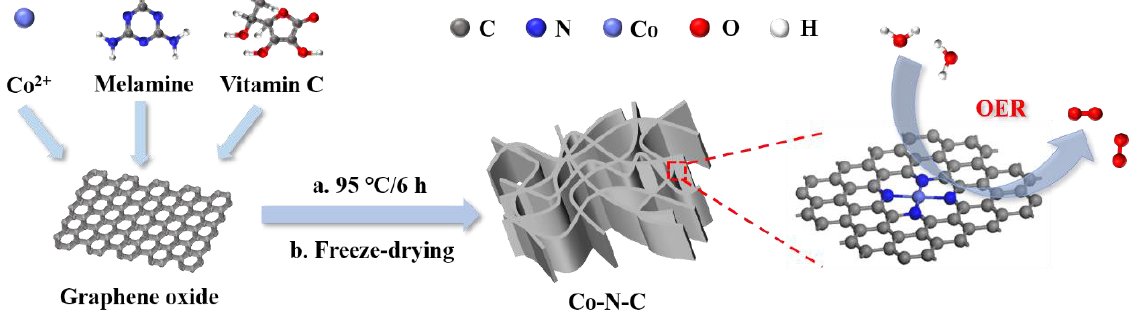
Figure 1. Schematic illustration of the preparation process of the Co-N-C aerogel electrocatalyst. Overall, structural characterization and OER activity of the preferably selected Co- N-C (0.5 wt% Co and 1 wt% N), Co-C (0.5 wt% Co), and GA are performed. Figure